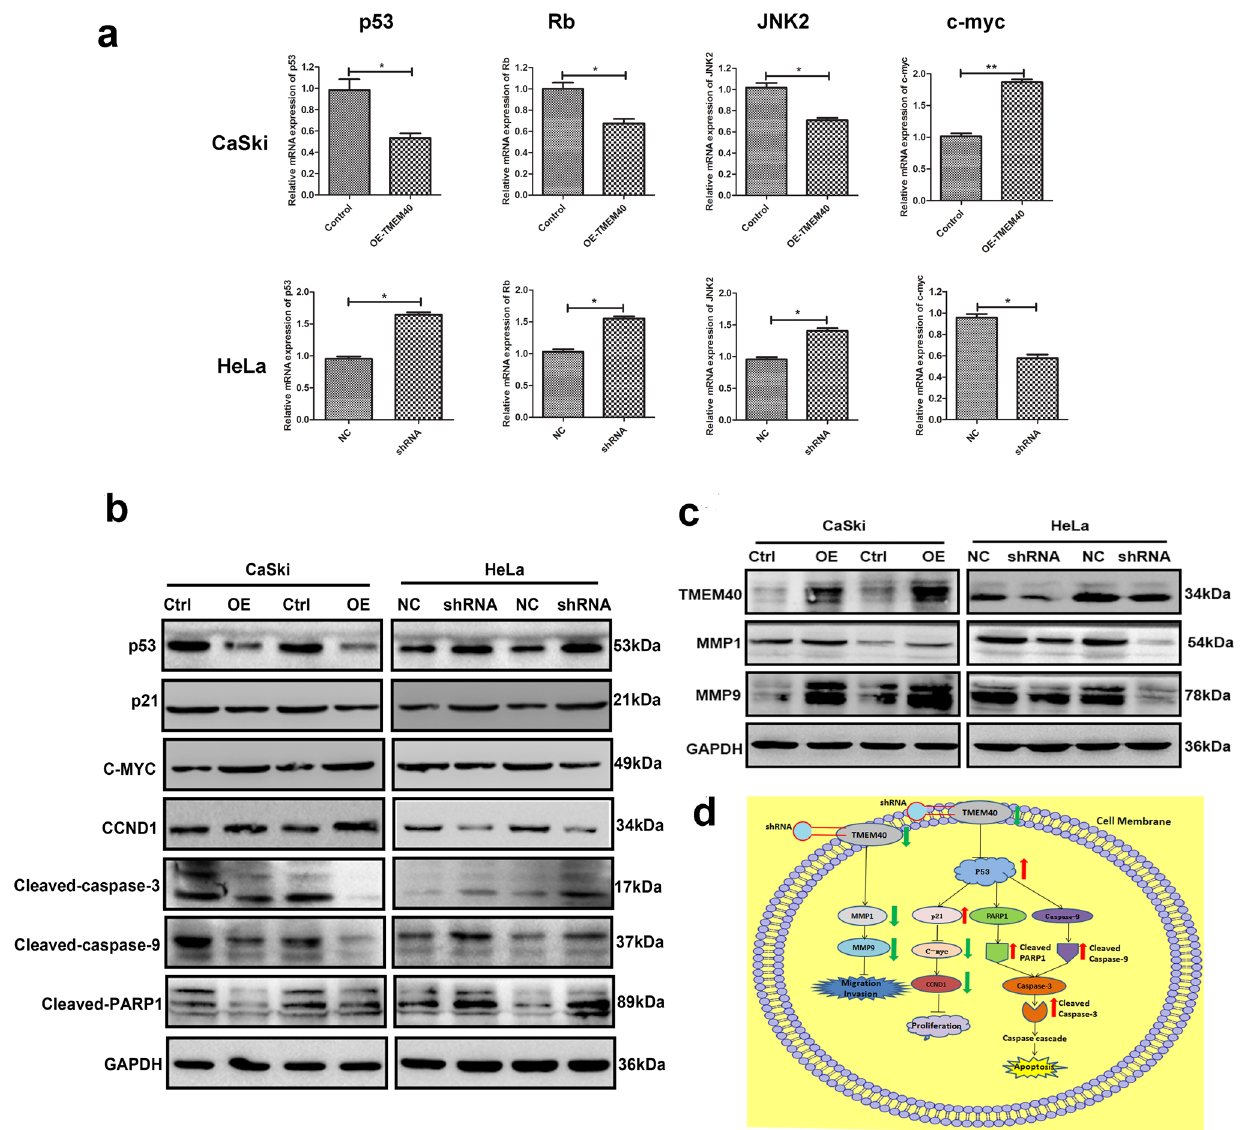
Fig. 7 TMEM40 acts as an oncogene via regulating the different signaling pathways. a , Quantitative RT-PCR of c-MYC, p53, Rb and JNK2 in CaSki and HeLa cells. b and c Western blot analysis of proliferation, invasion, apoptosis related signals in CC cells. d The working model of TMEM40-regulated CC progression and development. Data are shown as mean ± SD. * P < 0.05, ** P <